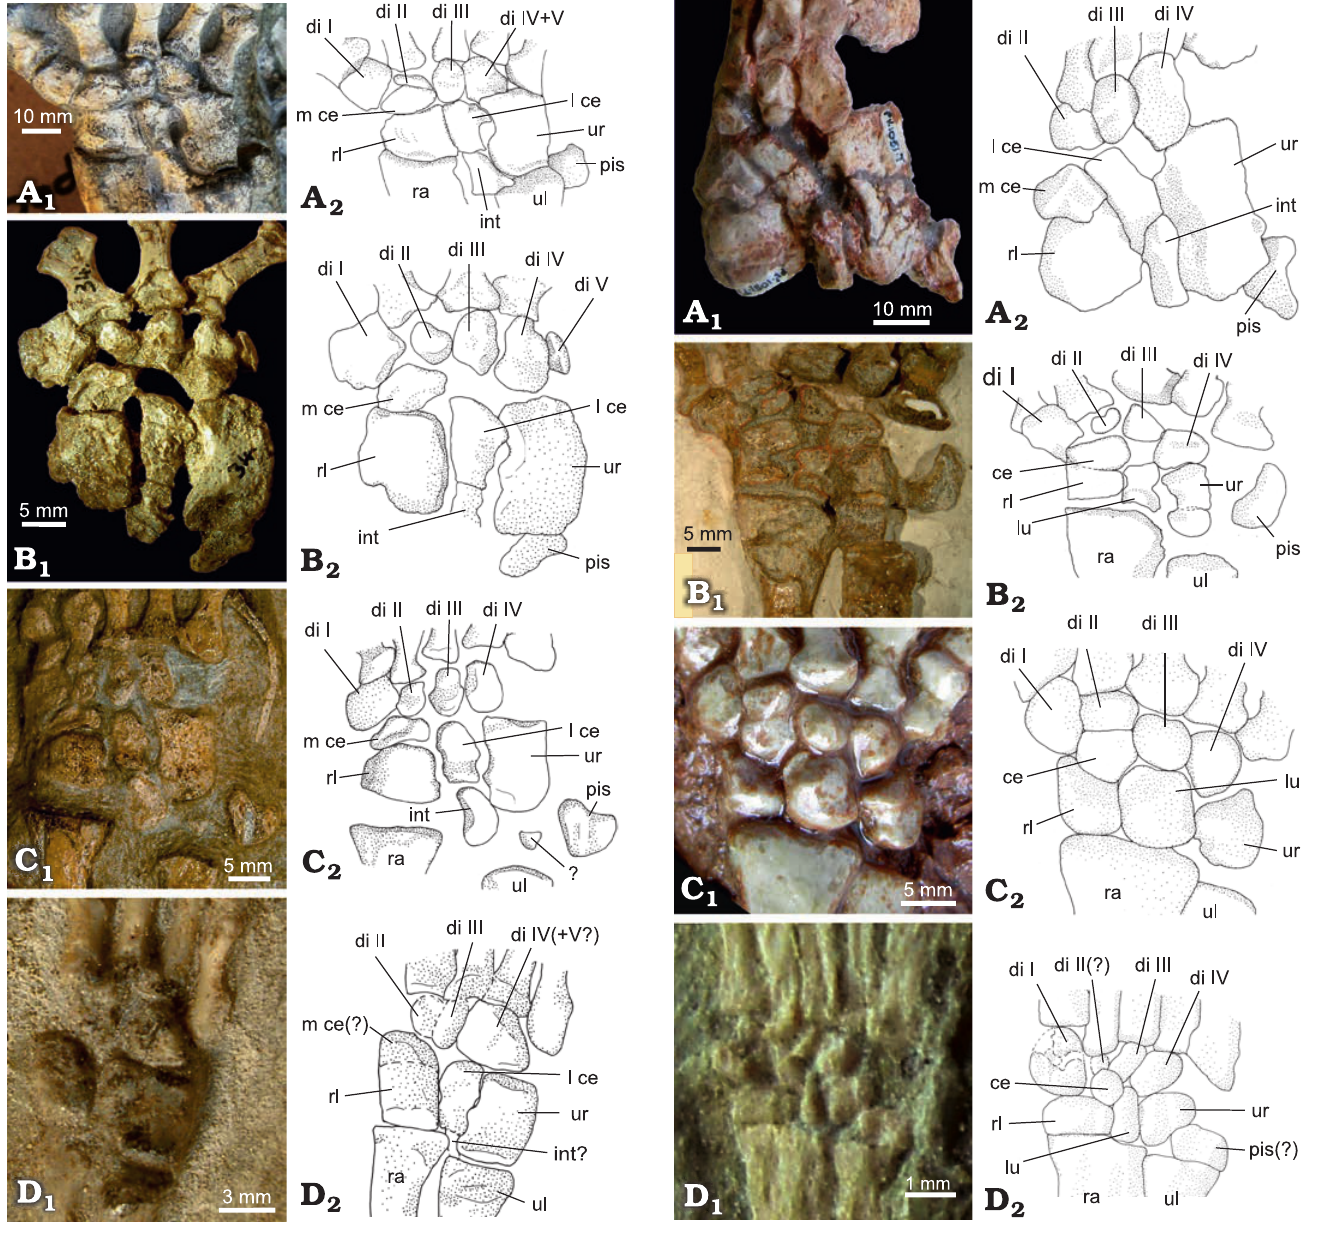
gnathus microps NHMUK R 5694 (Fig. 9). We do not know